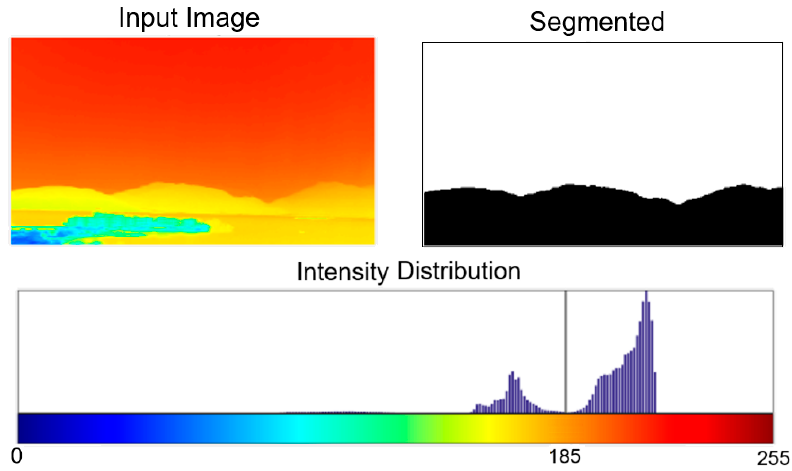
Figure 8. Threshold segmentation image after gray weighted average.